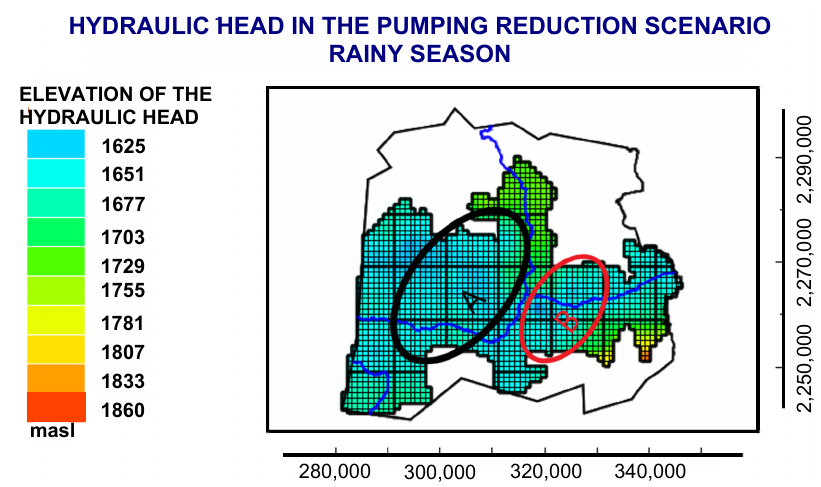
Figura 3.14: Elevaci´on de la carga hidr´aulica del a˜no 2030 a trav´es del escenario Reducci´on de Figure 24. Elevation of the hydraulic head of the year 2030 through the pumping reduction scenario in the rainy Bombeo en la Temporada de Secas.